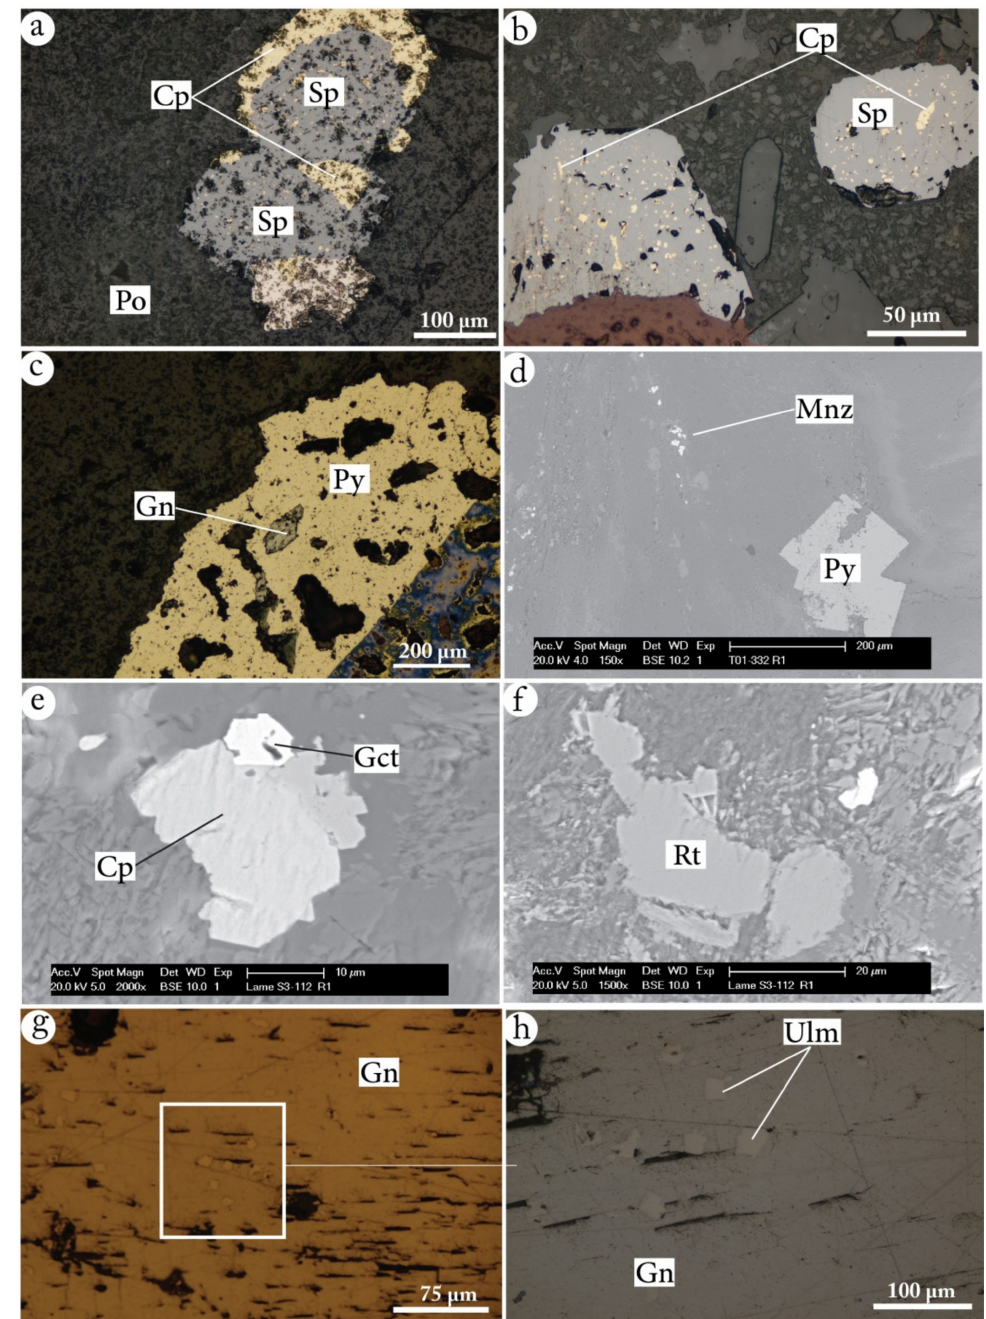
Figure 14. Microphotographs of ore minerals in gangue of quartz, calcite, and chlorite (reflected light; a – c , g , h ) and back-scattered electrons (BSE; d – f ). ( a ) Pyrrhotite and chalcopyrite coexisting with sphalerite in quartz-calcite-chlorite gangue; ( b ) sphalerite grains with inclusions of chalcopyrite in quartz-chlorite gangue; ( c ) pyrite minerals containing galena inclusions in a quartz-chlorite vein; ( d ) automorphic pyrite crystal sandstone; ( e , f ) association of chalcopyrite- glaucodot with rutile in dolerite; ( g , h ) inclusions of ullmannite crystals in galena. Po: pyrrhotite; Sp: Sphalerite; Cp: Chalcopyrite; Gn: Galena; Py: Pyrite; Gct: Glaucodot; Mnz: Monazite; Rt: Rutile; Ulm: